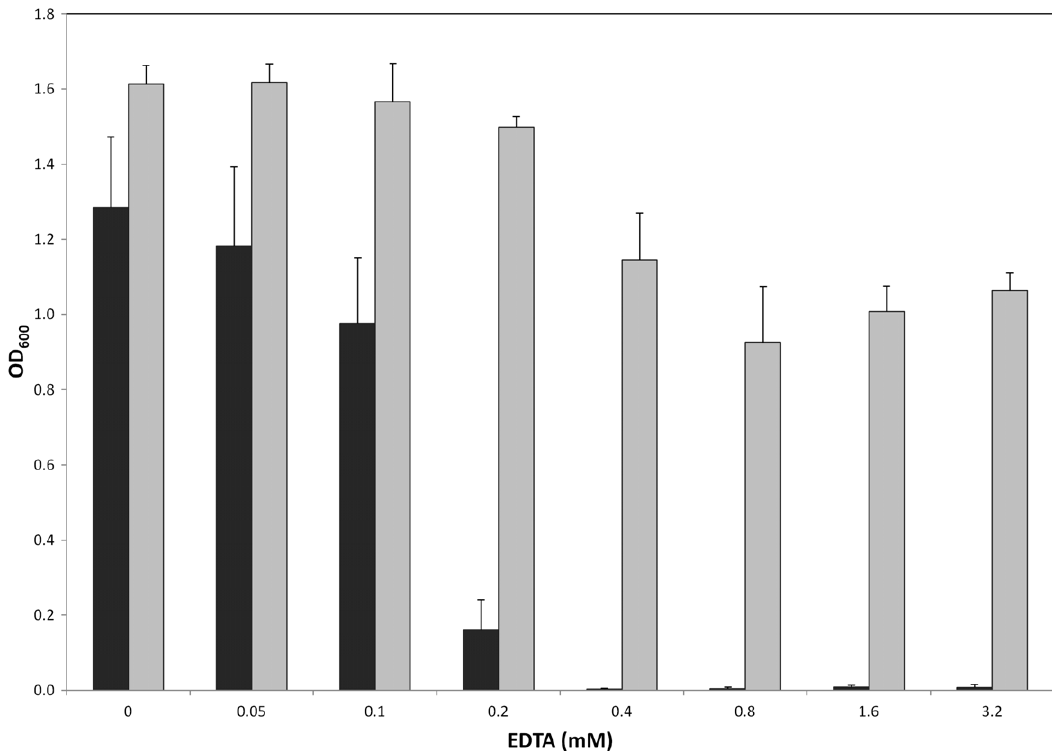
Figure 4. Inhibition of growth by EDTA. Increasing concentrations of EDTA was added to TY media inoculated with either S. meliloti (black bars) or E. coli (grey bars). The absorbance of the culture at 600 nm (OD600) was measured , 20 hrs post inoculation. The average of three independent experiments is shown with error bars representing the standard deviation.